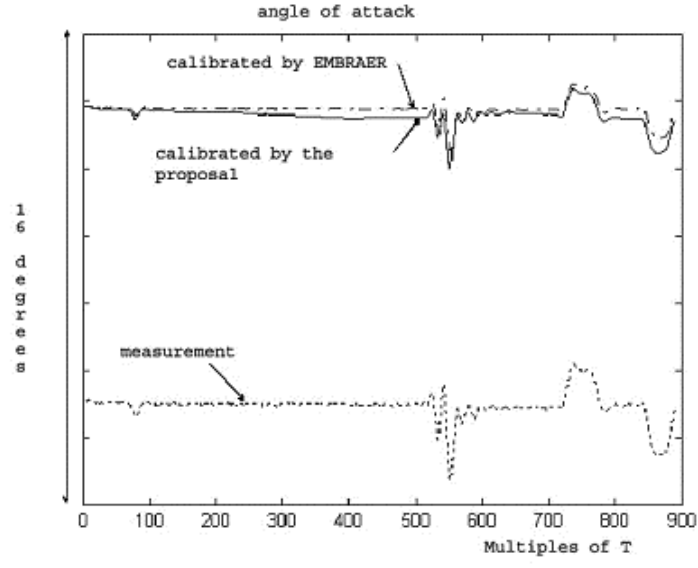
Fig. 4. Measured and calibrated values for the angle of attack.